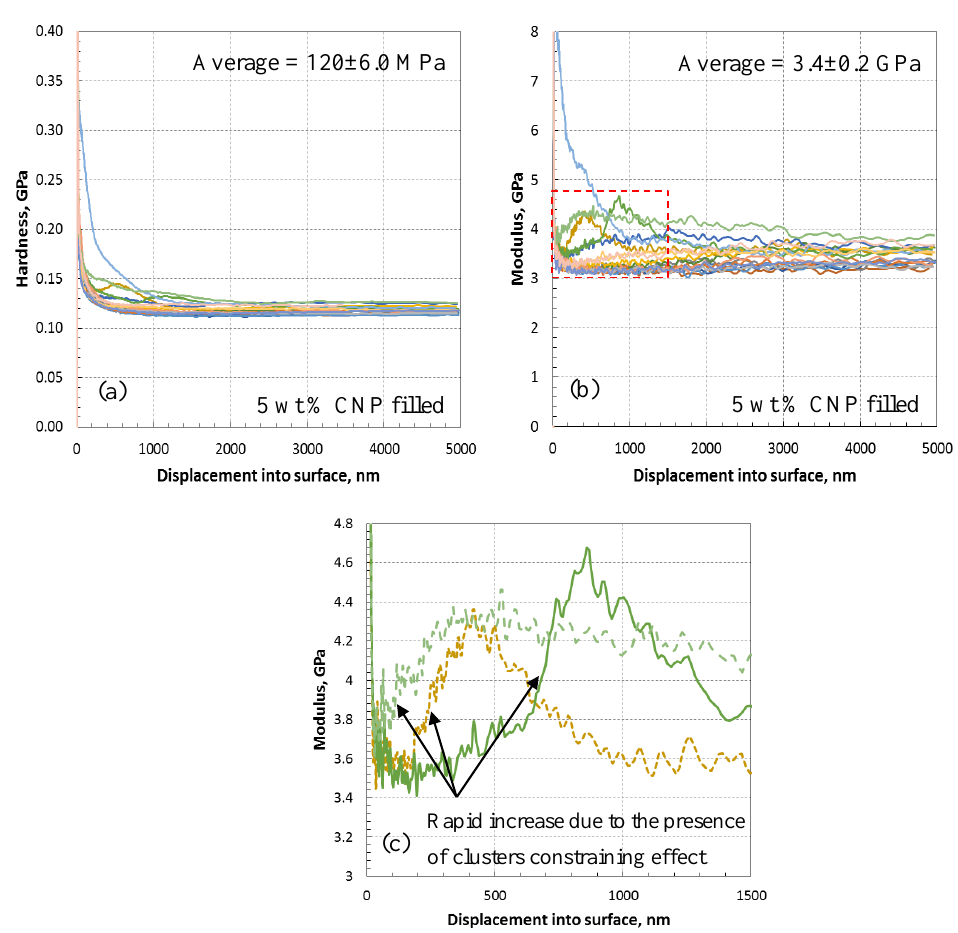
Figure 10. Nanoindentation data of 5 wt % CNP filled epoxy; ( a ) variation of hardness with depth showing steady hardness at or near CNPs (Figure 11) with average hardness of 120 ± 6 MPa, ( b ) variation of modulus with depth showing steady and scattered modulus at or near CNPs (Figure 11) with average modulus of 3.4 ± 0.2 GPa, ( c ) magnified view of dashed-line region from subfigure ( b ). Polymers 2018 , 10 , 1106